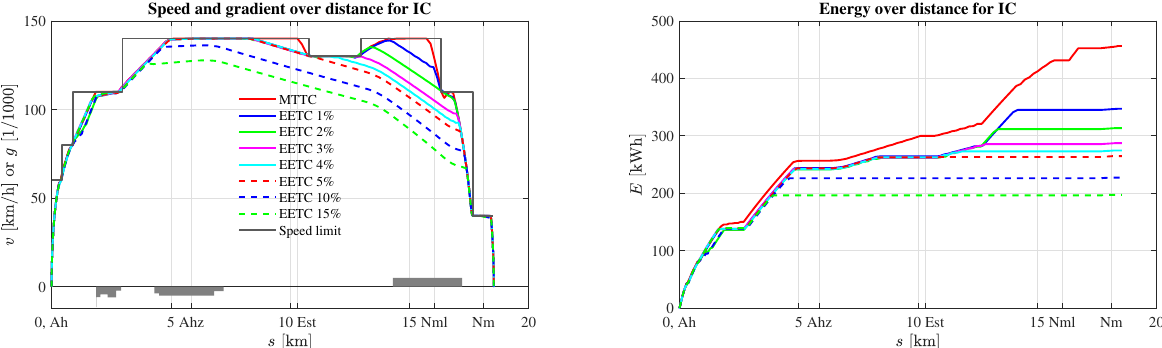
Figure 4: The left plot shows for the case Ah-Nm IC with varying running time supplements the speed/gradient–distance profile of the MTTC and EETC driving strategies. The right plot indi- cates the energy–distance profile of the MTTC and EETC driving strategies for the case Ah-Nm IC.